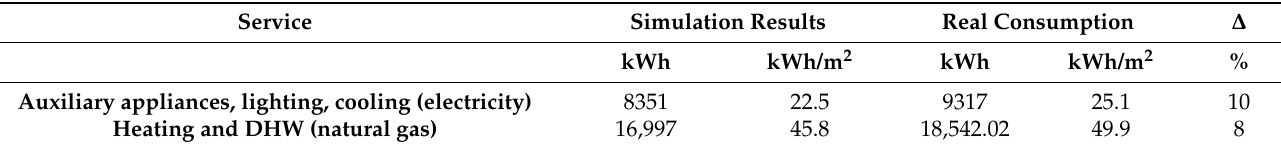
Table 5. Comparison between real consumption and consumption results from simulation.